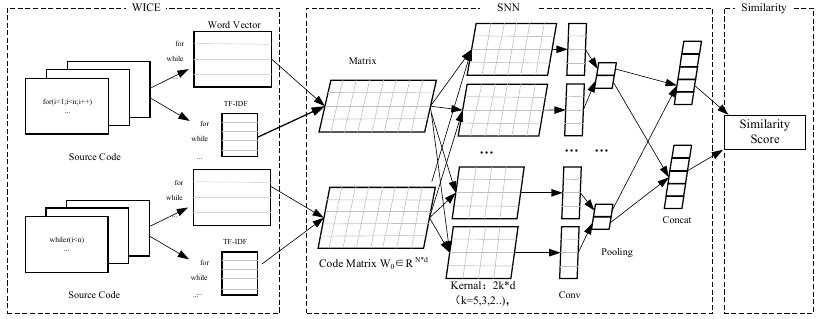
Figure A2. WICE-SNN Framework.